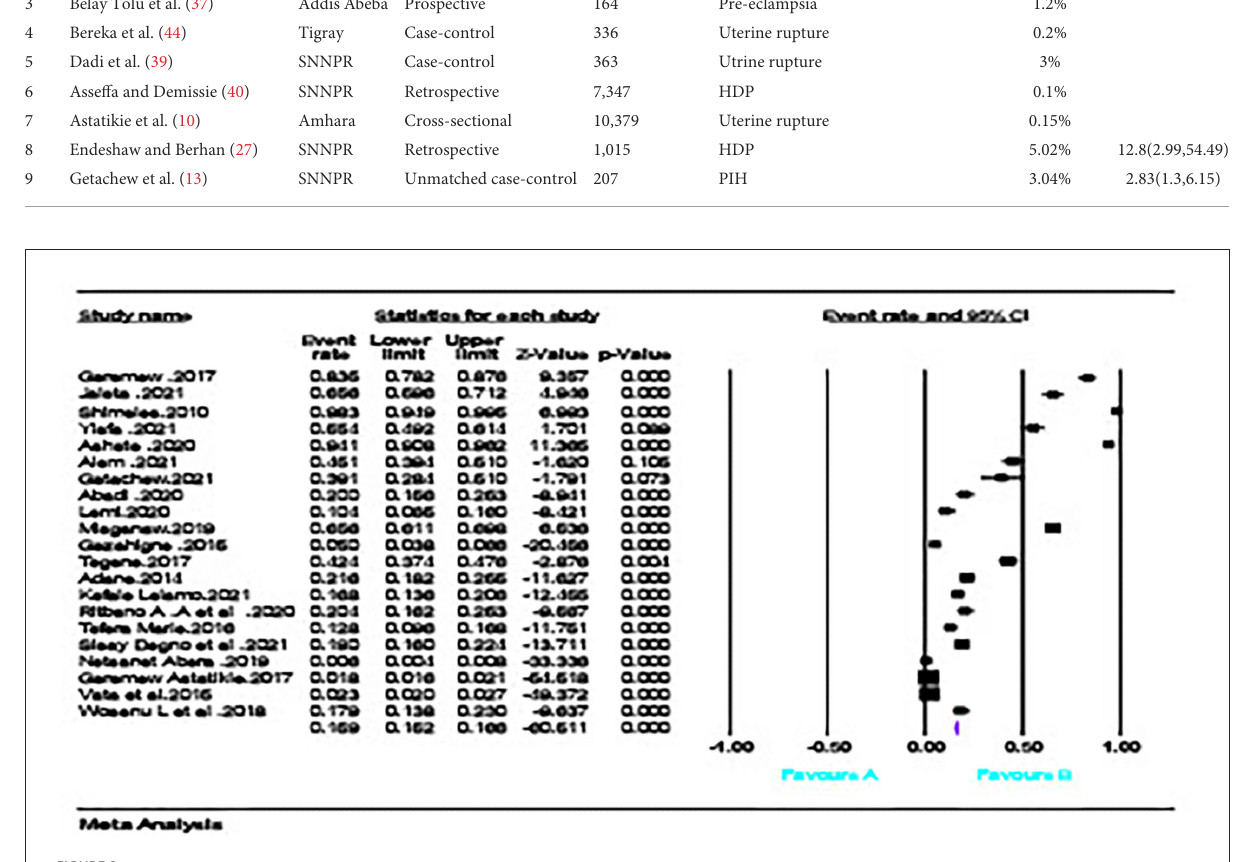
FIGURE2 Magnitude of adverse maternal outcome following obstetrics